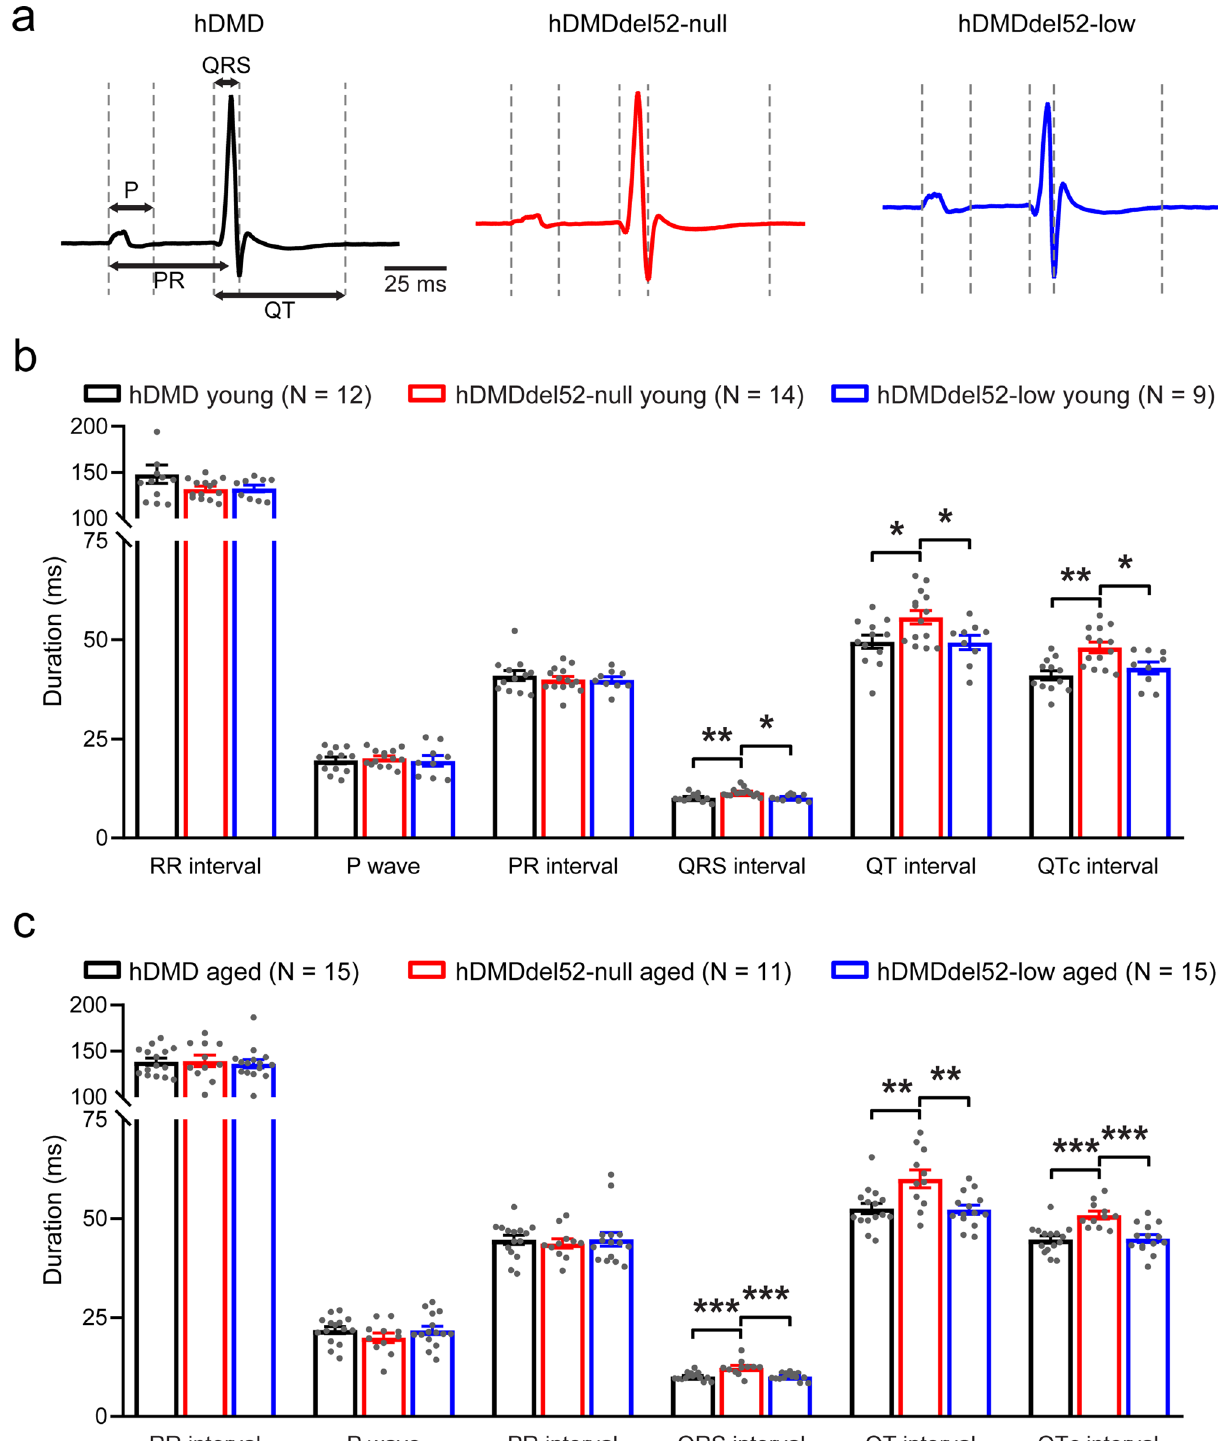
Figure 1. ECG measurements in young and aged mice show ventricular conduction slowing and delayed repolarisation in the absence of dystrophin, prevented by low expression of dystrophin. ( a ) Representative averaged ECG traces obtained in young hDMD (black), hDMDdel52-null (red), and hDMDdel52-low (blue) mice. ( b ) Average ECG characteristics of young hDMD (2.3 ± 0.1 months), hDMDdel52-null (2.4 ± 0.1 months), and hDMDdel52-low mice (2.4 ± 0.1 months). ( c ) Average measurements in aged hDMD (8.6 ± 0.5 months), hDMDdel52-null (10.0 ± 0.5 months), and hDMDdel52-low mice (8.4 ± 0.5 months). N represents the number of animals measured. * P < 0.05, ** P < 0.01, *** P < 0.001 (one-way ANOVA with Tukey’s post-hoc